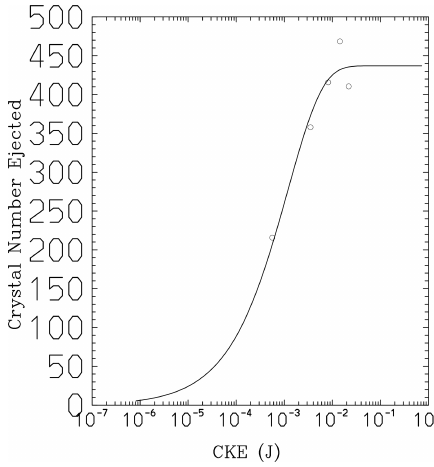
Figure 5. Measurements of numbers of fragments per hail–hail (2cm diameter) collision (circles), as a function of initial CKE, which we inferred, using Hertz theory from the published data of the experiment by Takahashi et al. (1995). Source: Phillips et al. (2017a). © American Meteorological Society. Used with per-